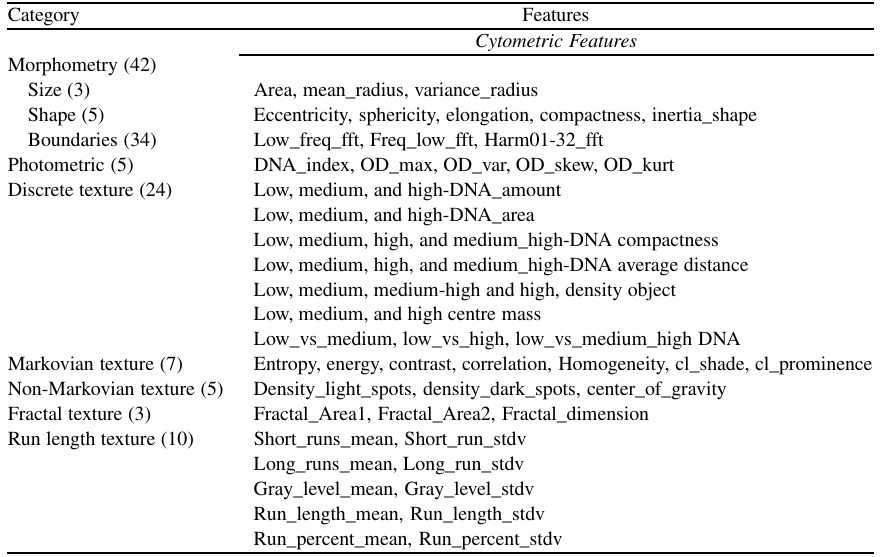
List of features used in this study per categories (see text) Category